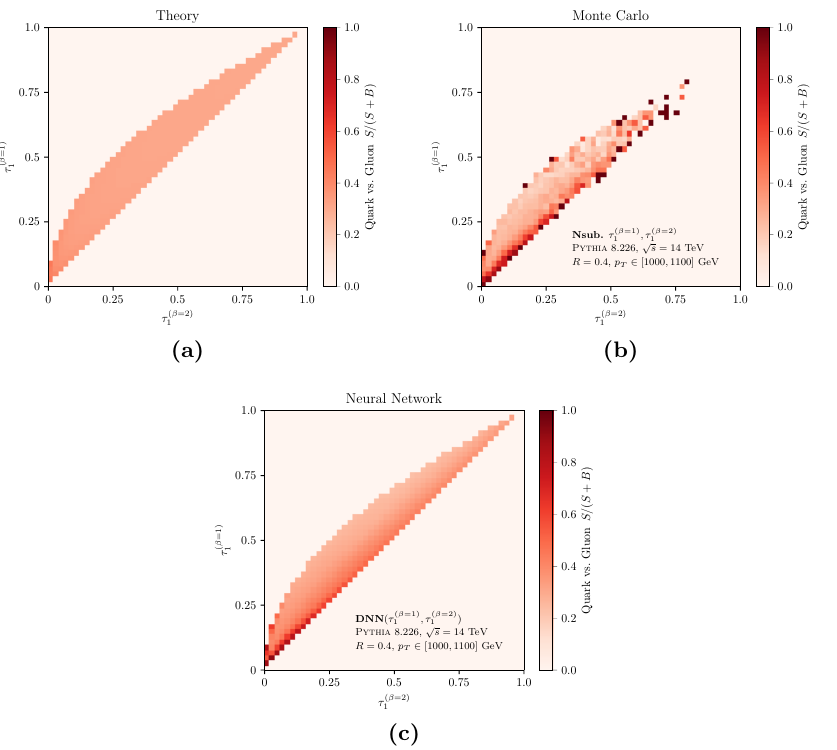
Figure 14. S= ( S + B ) for quarks ( S ) vs. gluons ( B ) in the ( (cid:28) ( (cid:12) =1) ; (cid:28) ( (cid:12) =2) ) phase space, determined 1 1 by (a) the prediction of eq. (5.8) using (cid:11) s = 0 : 118, (b) Monte Carlo histogram counts, and (c) the output of a neural network trained to classify quarks and gluons. The prediction successfully captures the qualitative features of the neural network decision boundaries and correctly predicts its saturation around C F = ( C F + C A ) 0 : ’